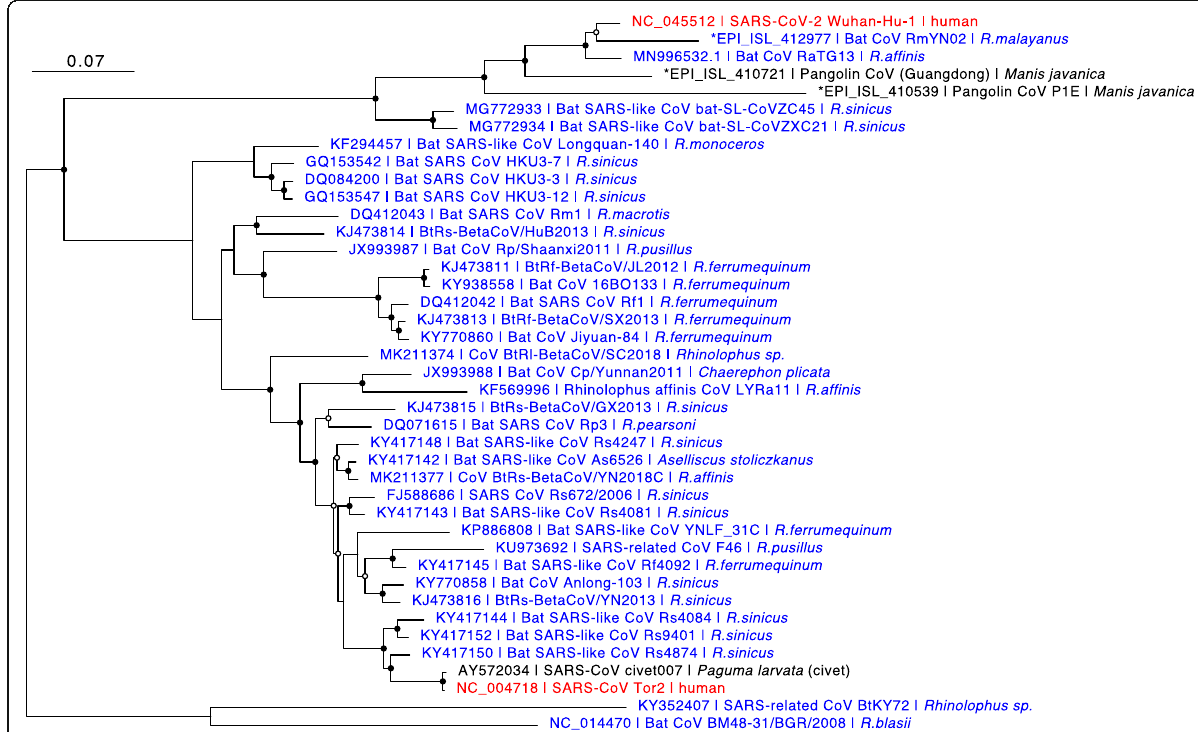
Fig. 2 Phylogeny of CoVs belonging to Sarbecoronavirus . ML-based phylogenetic tree of 41 CoVs belonging to Sarbecoronavirus including SARS- CoV-2. Whole genome sequences were used for the analysis. We generated the multiple alignment of the sequences using L-INS-i of MAFFT version 7.453 [9], and the nucleotide substitution model GTR+I+G was selected using ModelTest-NG [13]. Based on the model, we constructed an ML tree using RAxML-NG [11], applying 1000 bootstrapping tests. Please see Fig. 1 legend for the details of this